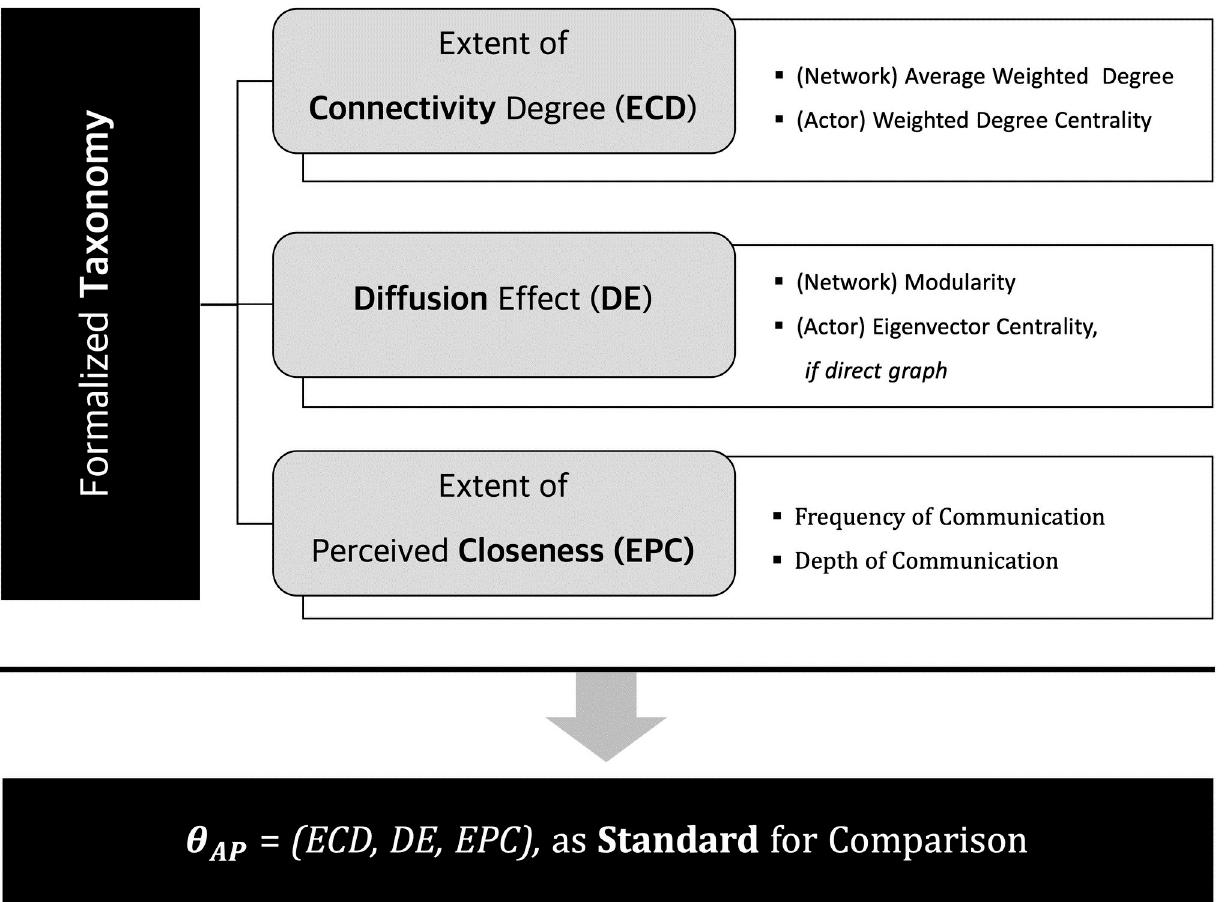
Fig 4. Formalized taxonomy comprising three dimensions: Extent of connectivity degree; diffusion effect; and extent of perceived closeness, and θ as standard for comparison.